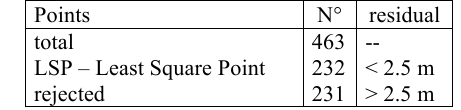
Table 1. Point in "Città metropolitana di Roma Capitale" area